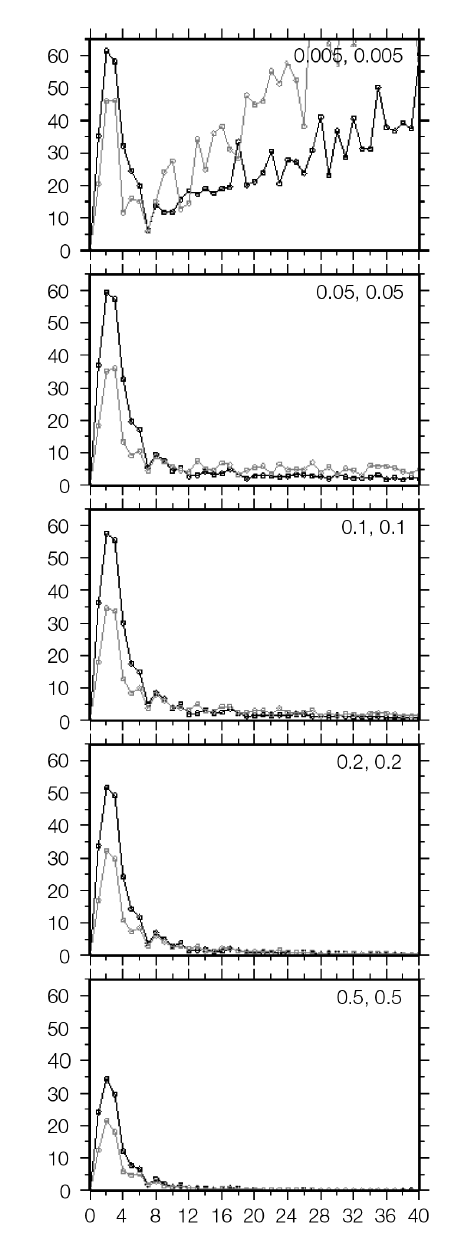
Fig. 4. Harmonic spectra of the images in fig. 3, plus (top panel) an obviously underdamped one, shown for comparison. Again, spectra associated with Utrecht and Harvard databases are in grey and black, respectively.